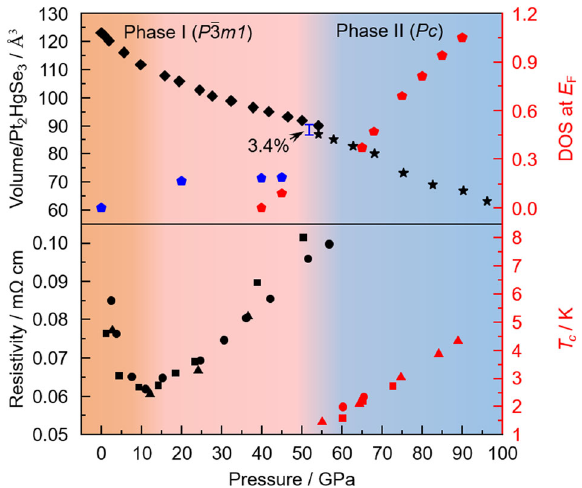
Fig. 6 Structure and electronic P-T phase diagram of Pt 2 HgSe 3 . The lattice volume, DOS at E F , resistivity at 1.8 K and T c for Pt 2 HgSe 3 is shown as a function of pressure. The upper panel shows the pressure dependence of the lattice volume calculated from experiments. The density of states (DOS) at the Fermi level for phase II also shown here. Black rhombus and star stand for lattice volume in phase I and phase II, respectively. Blue and red pentagons stand for DOS at the Fermi level for phase I and phase II. The lower panel shows the superconducting T c as function of pressure and resistivity at 1.8 K for Pt 2 HgSe 3 in different runs. The values of T c onset were determined from the high-pressure resistivity. Dot, diamond, and triangle stand for ρ ( T ) measurements in run I, run II, and run III, respectively. Black and red stand for resistivity at 1.8 K and T c ,